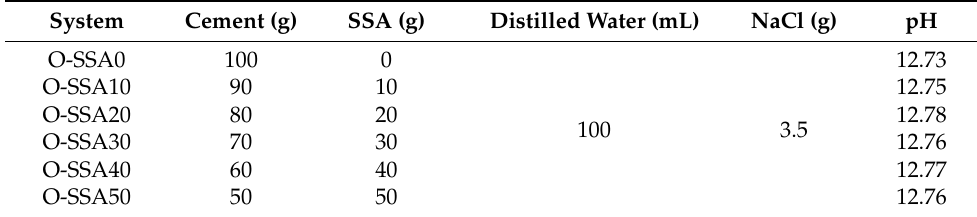
Table 2. Formulation of chloride contaminated various cement